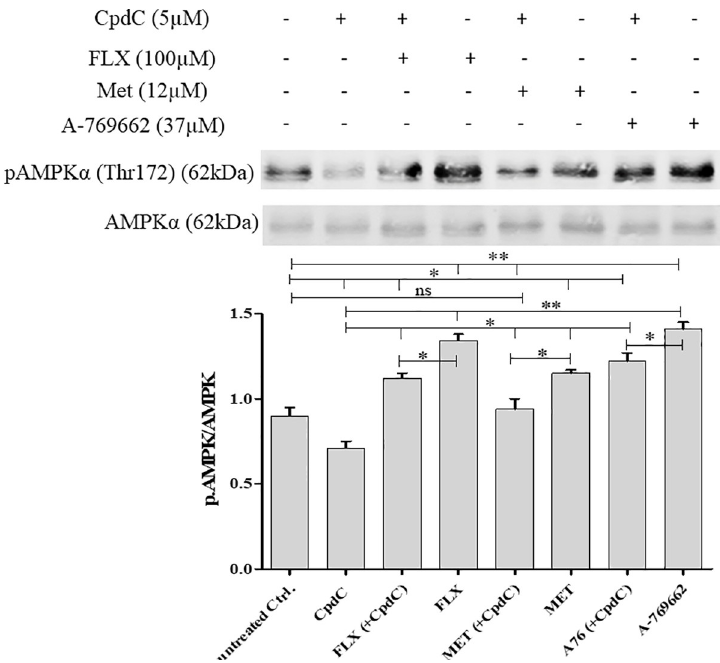
Fig 6. Effect of Compound C on FLX, MET, or A-769662 induced AMPK phosphorylation. MLTC-1 cells were preincubated with or without compound C (5 μ M) for 30 min before the addition of 100 μ M FLX or 12 μ M MET or 37 μ M A-769662, and incubated for an additional 60 min. The experiment was performed 4 times independent experiments (n = 4). Ratio values are means ± SEM. Results were analyzed by one-way ANOVA, followed by the Dunnett’s test posttest). � : significant difference ( � P < 0.05; �� P < 0.01), ns: no significant